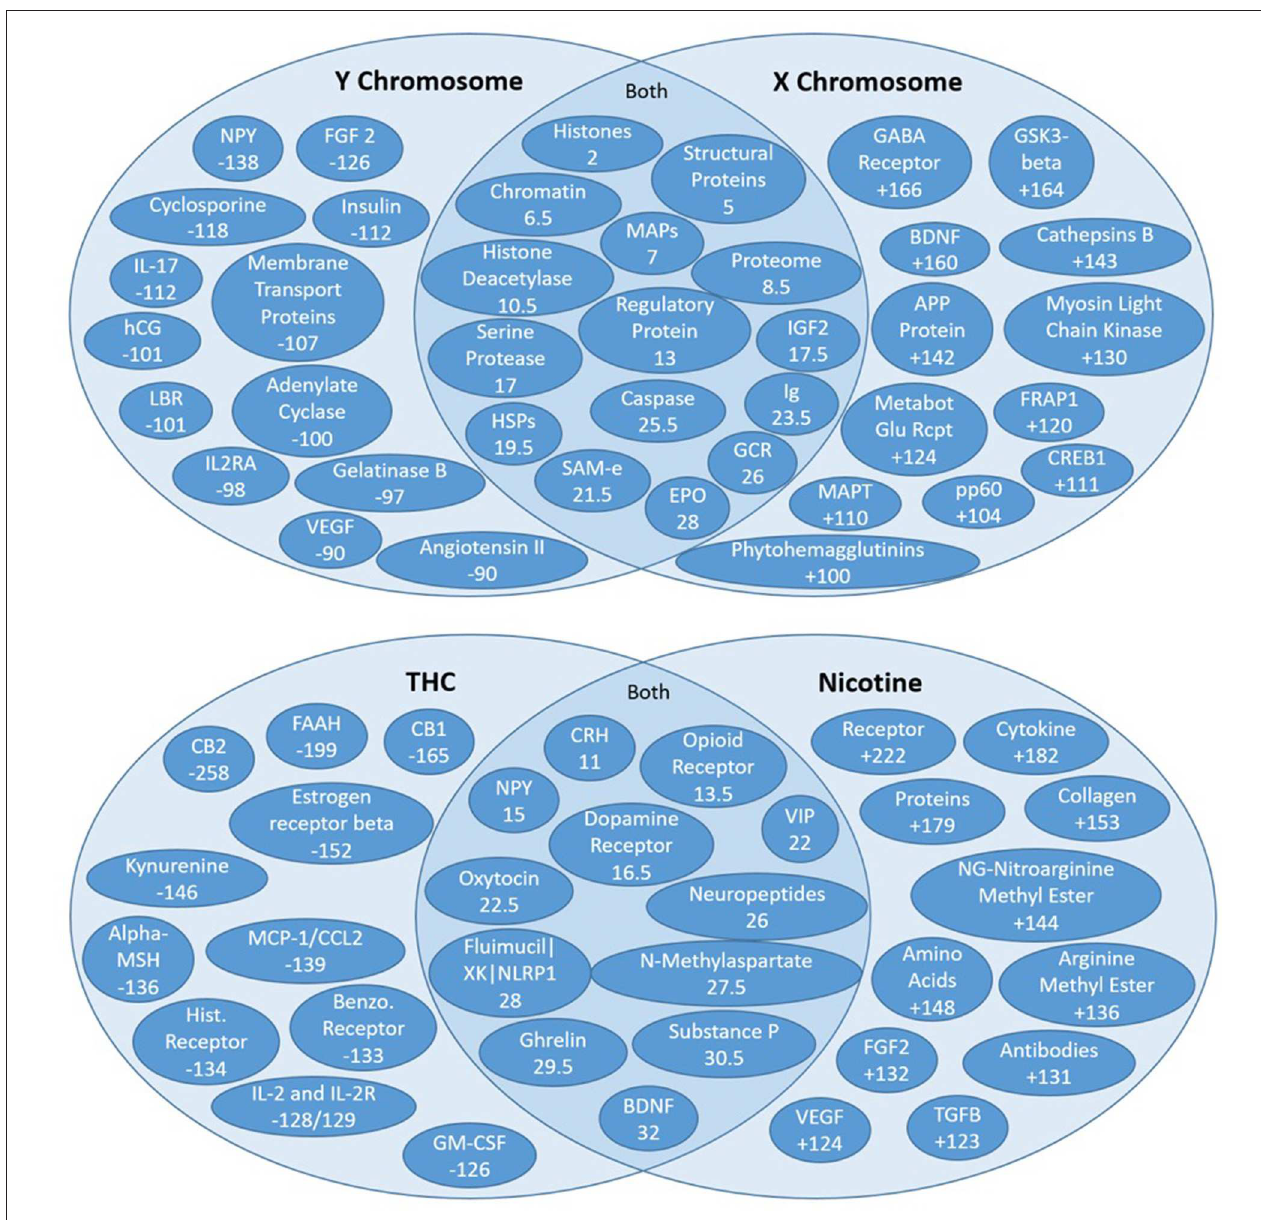
FIGURE 8 | High residual assessment of rankers. Numbers in the overlapping regions represent the highest average ranking between the two target nodes. (Top) Comparing the shared source node rankings between the X and Y chromosomes. The non-overlapping regions of the Venn diagrams contain the nodes with the largest discrepancy between the two rankers (e.g., NPY was ranked 138 spots higher with respect to the Y chromosome than the X chromosome). (Bottom) Comparing the shared source node raking between nicotine and